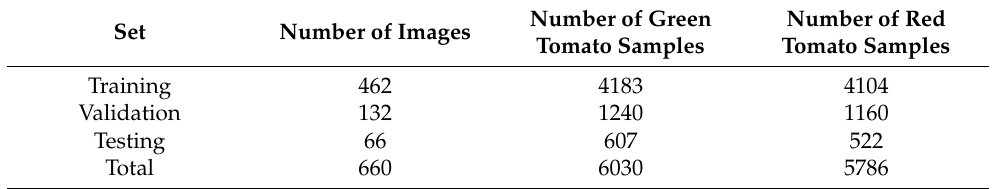
Table 1. Number of tomato images and sample instances in the constructed